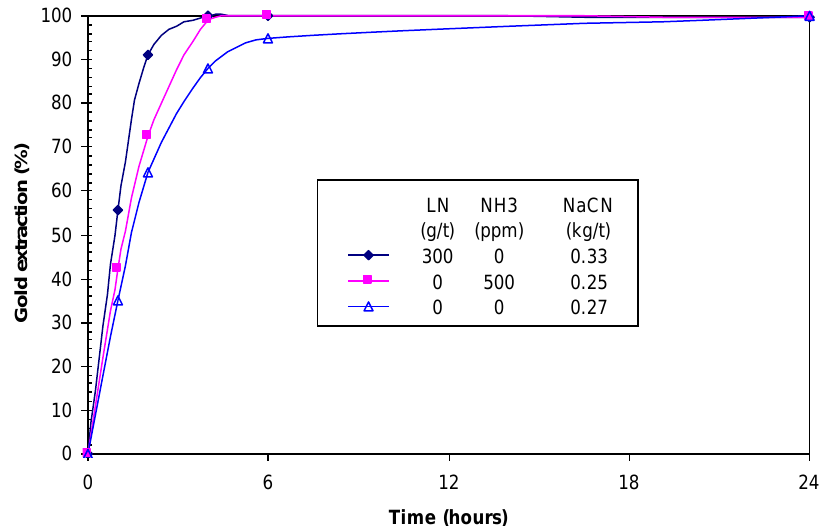
Figure 10. Effect of lead nitrate and ammonia on gold extraction in presence of chalcopyrite; 0.3% Cu, 500 ppm NaCN, 8 ppm